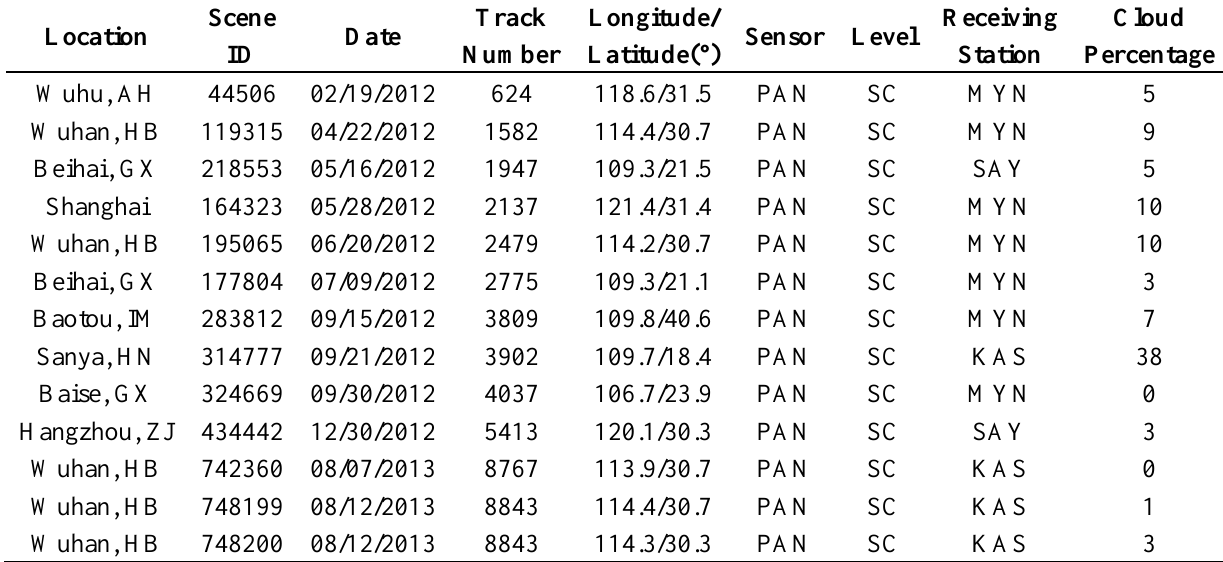
Table 3. Overview of the test datasets. SC, sensor-corrected; MYN, Miyun; SAY, Sanya; KAS,